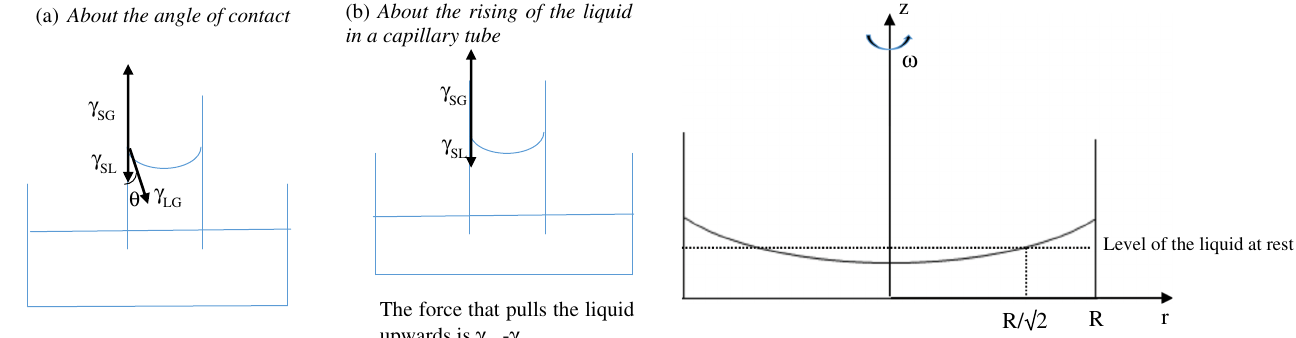
FIG. 4. Rotating centrifuge filled with liquid (angular velocity ω ): level of liquid in the absence of a lid in the stationary regime